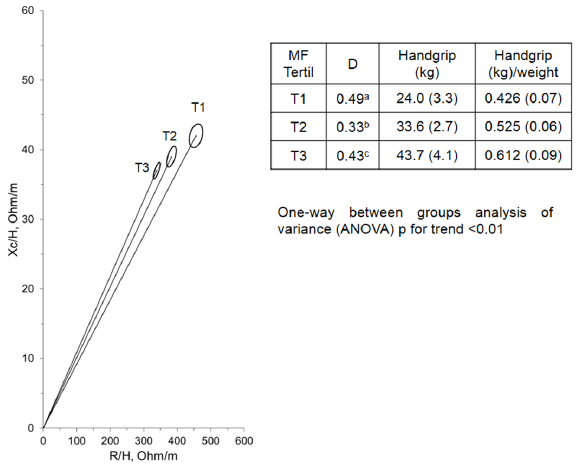
Figure 1. Partial correlation between muscle strength and phase angle in healthy men.